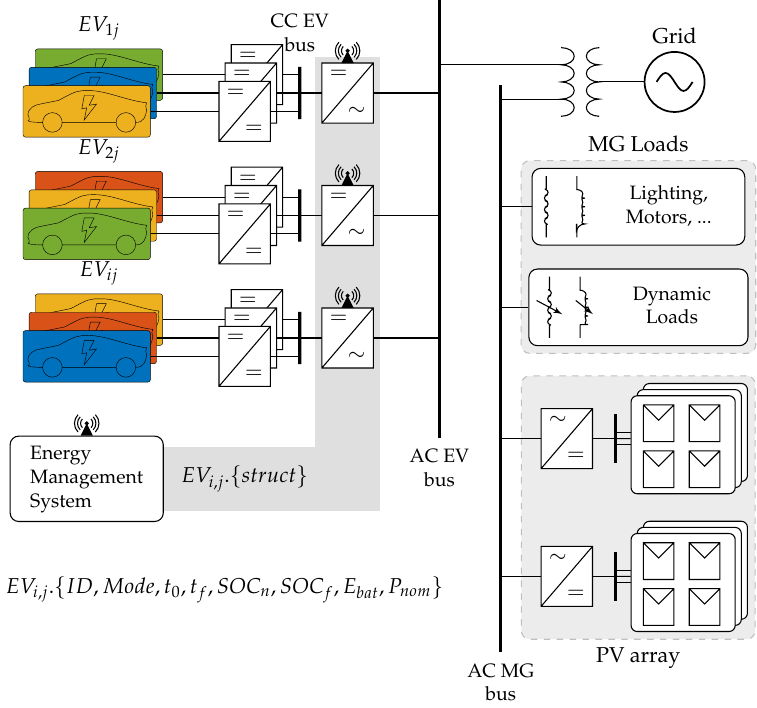
Figure 2. Physical diagram of the proposed